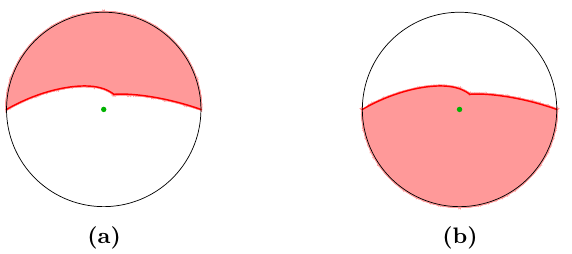
Figure 14. Slicings of annulus brane configurations used in the computation of their Euclidean on-shell actions. We identify u with the angular ( τ ) direction in (3.14). In (b), the conical defect is integrated over in the slice, but it does not actually contribute to the on-shell action because it is orthogonal to each Cauchy